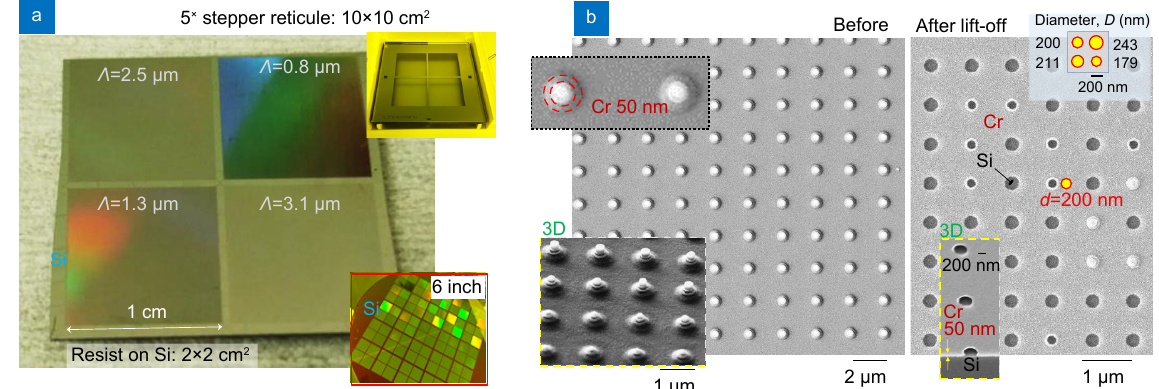
Fig. 5 | ( a ) Photo of the dot patterns (resist on Si) after exposure, development and dicing. Insets: (bottom) image of the entire 6-inch Si wafer after exposure and development; (top) the stepper reticle used for the i-line (365 nm Hg) 5 × reduction (positive resist: the exposed regions are re- moved). ( b ) SEM images of 50-nm Cr film e-beam evaporated on 700-nm-thick resist patterns before and after lift-off; exposure was made by projection lithography on Si. Circular marker shows d = 200 nm for comparison with developed holes. Bottom-insets shows slanted-view images of the patterns after lift-off. Top-right inset shows the hole openings D for the four segments of PhC patterns with different periods shown in